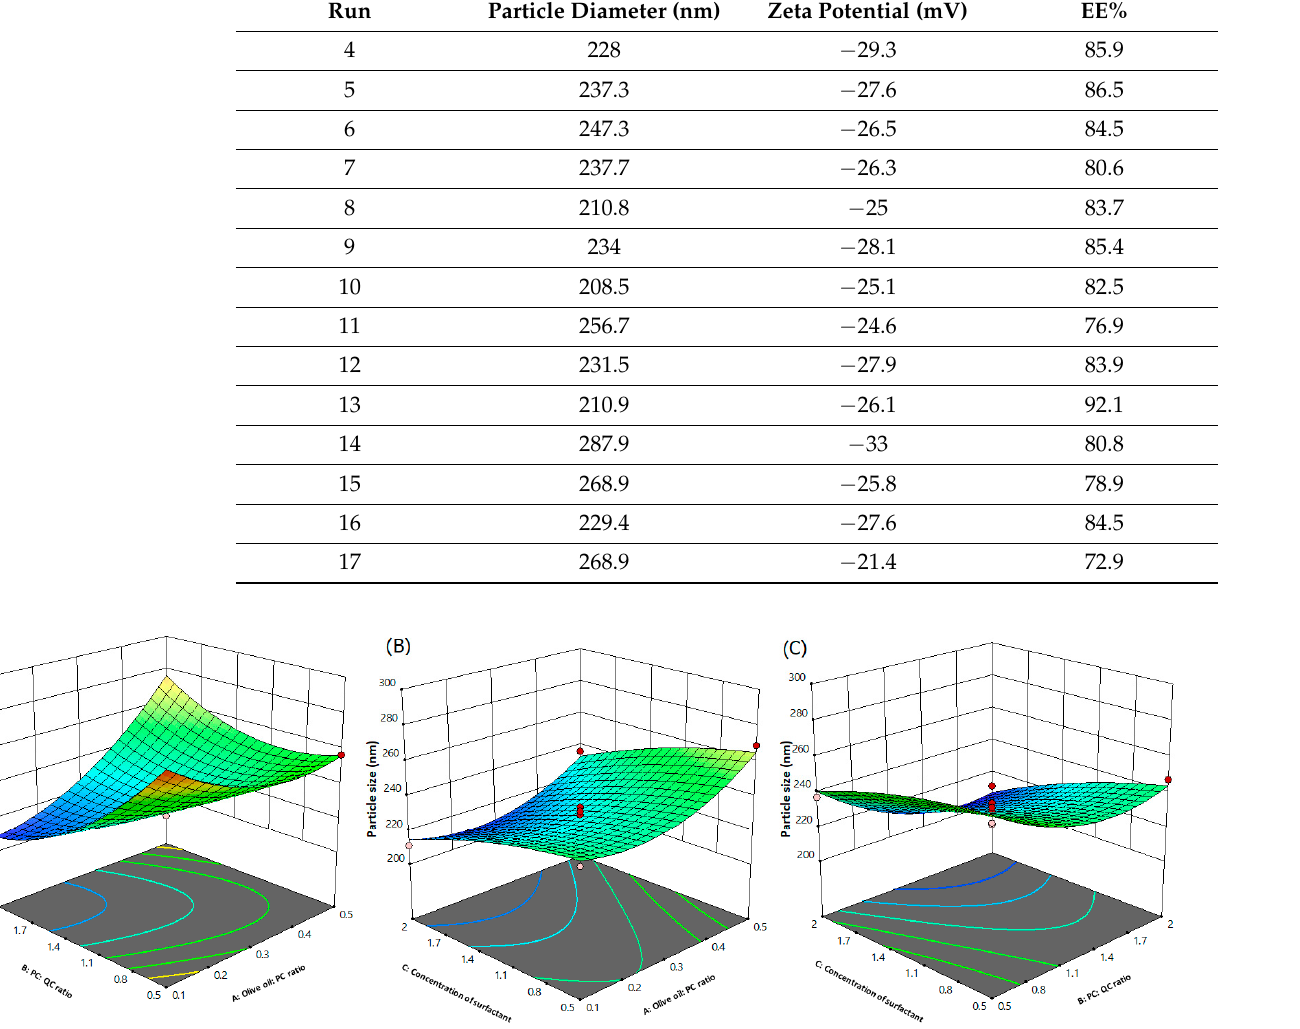
Figure 2. Three-dimensional response surface plots indicating the combined influence of: ( A ) olive oil/PC and QC/PC ratios, ( B ) olive oil/PC ratio and concentration of surfactant and ( C ) QC/PC ratio and concentration of surfactant on particle size.